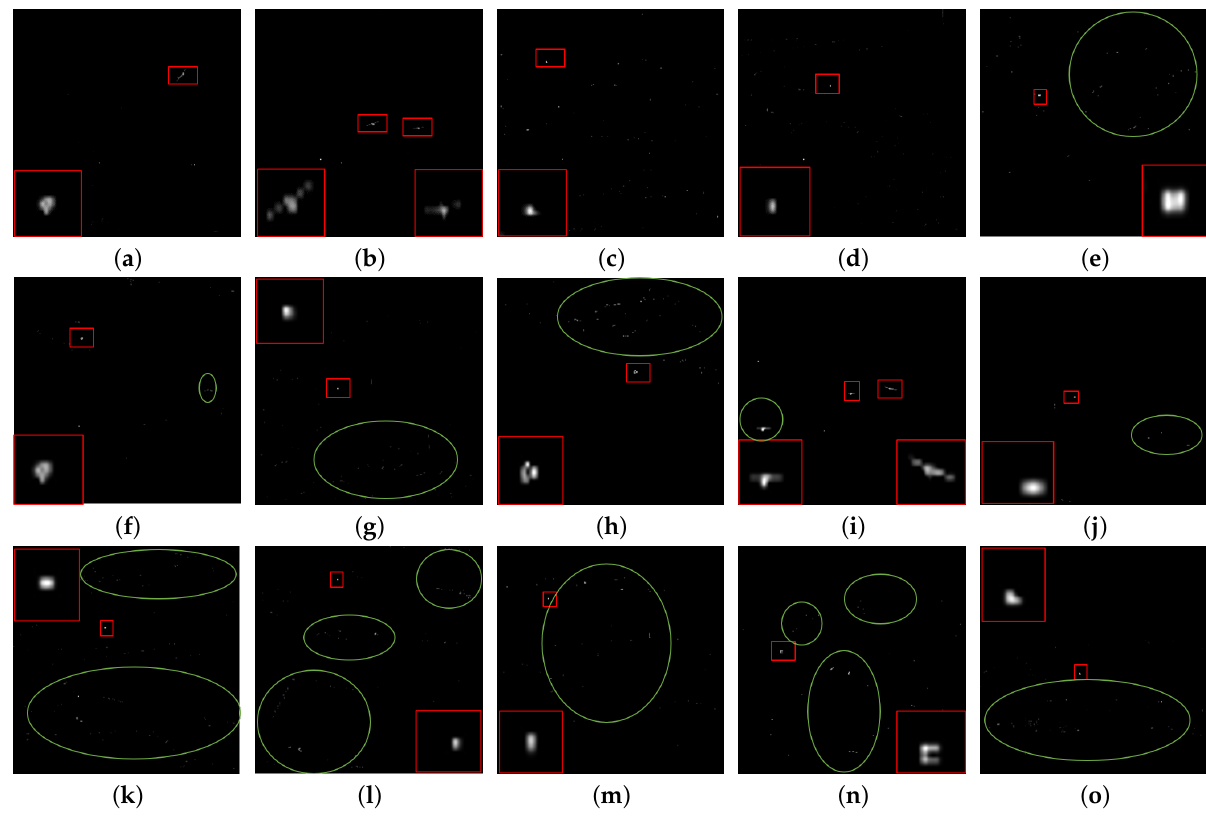
Figure 15. Three-dimensional displays of the detection results in Figure 14.